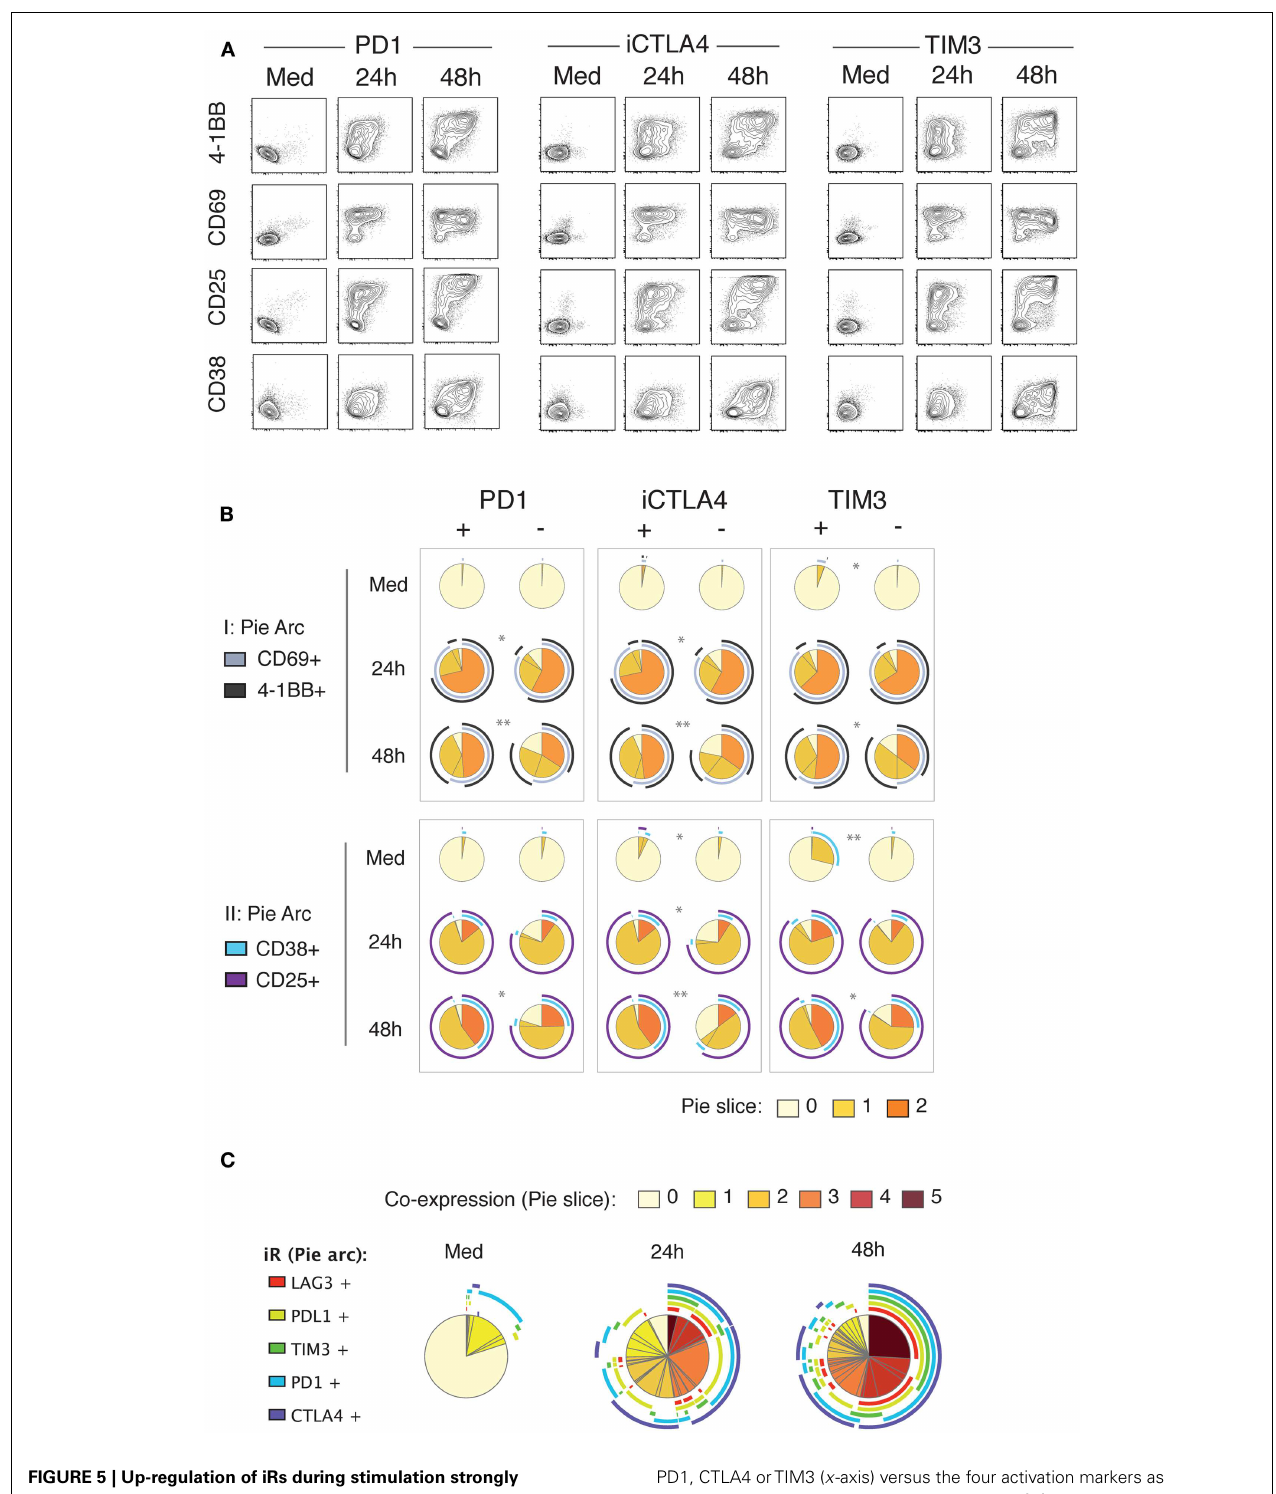
FIGURE 5 | Up-regulation of iRs during stimulation strongly correlates with activation markers . Healthy donor PBMC were stimulated for 24 and 48h with anti-CD3 and anti-CD28 antibodies. CD8T cells were analyzed for co-expression of iRs and activation markers in two separate panels (I and II). (A) . Representative plot of